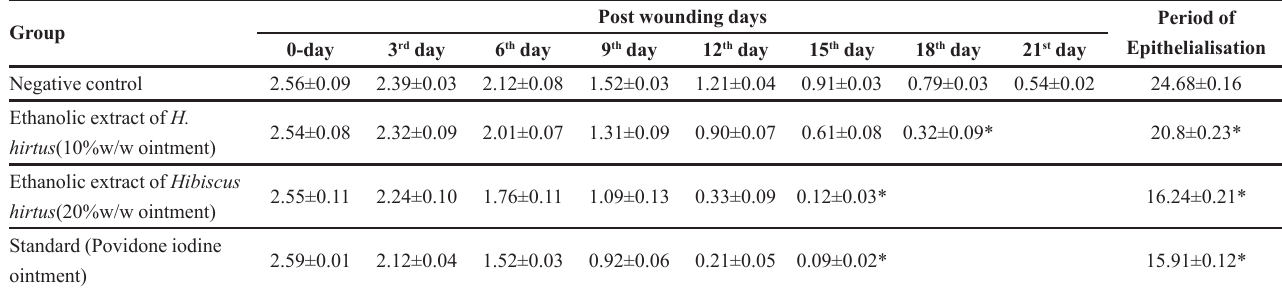
TABLE II - Effect of topical application of ethanolic extract of Hibiscus hirtus on healing of excision wound model